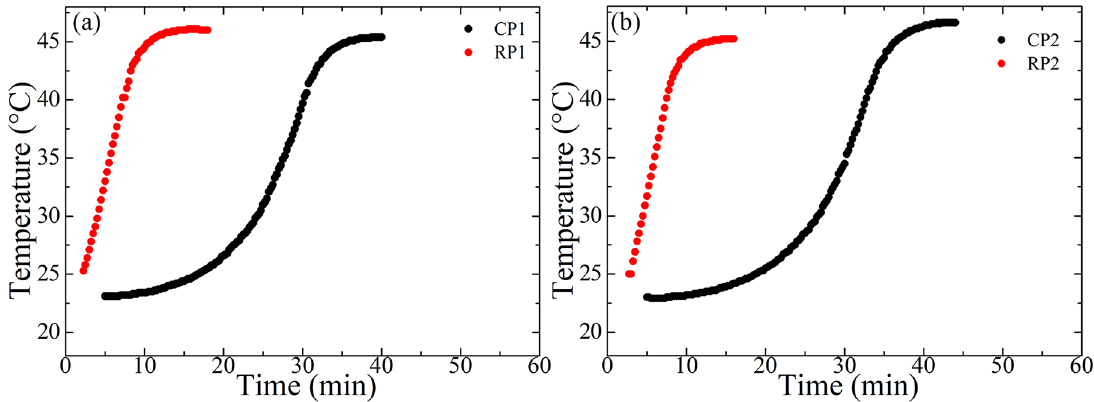
Figure 8. Temperature versus time of (a) CP1 and RP1 pastes and (b) CP2 and RP2 pastes.